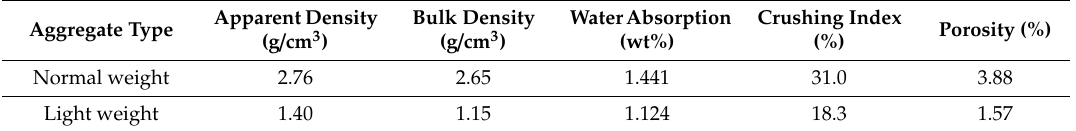
Table 3. Physical properties of normal weight and lightweight aggregates.